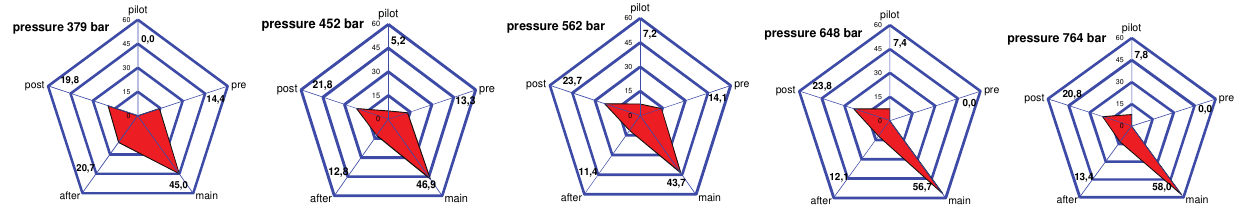
Fig. 13. Percentage share of individual portions of dose in total amount of supplied fuel for the third group of the measurements